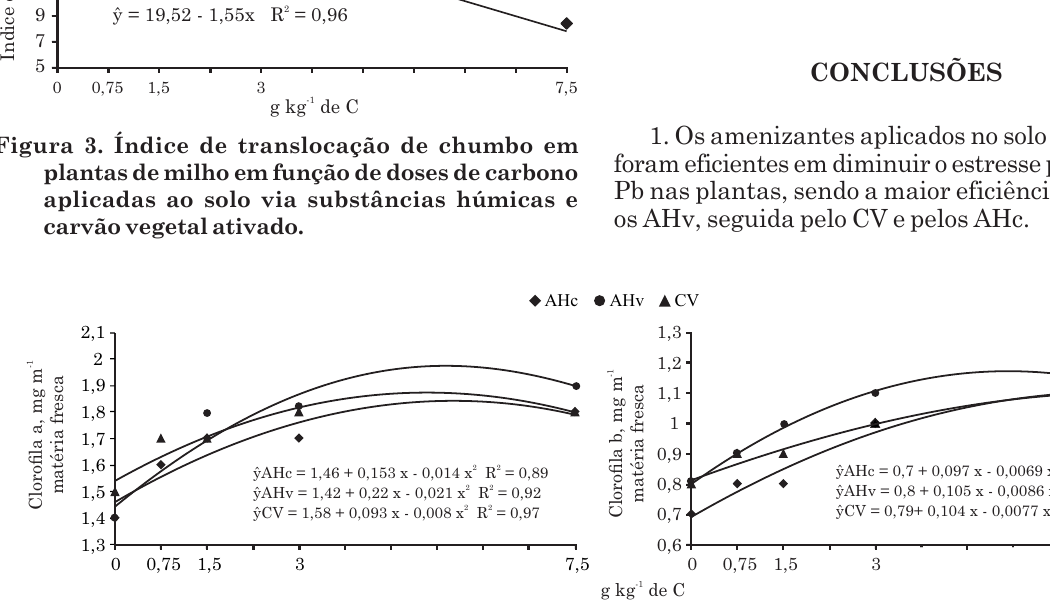
Figura 4. Teor de clorofila a e b em plantas de milho, em função de doses de carbono aplicadas ao solo via ácidos húmicos comerciais (AHc), ácidos húmicos extraídos de vermicomposto (AHv) e carvão vegetal ativado